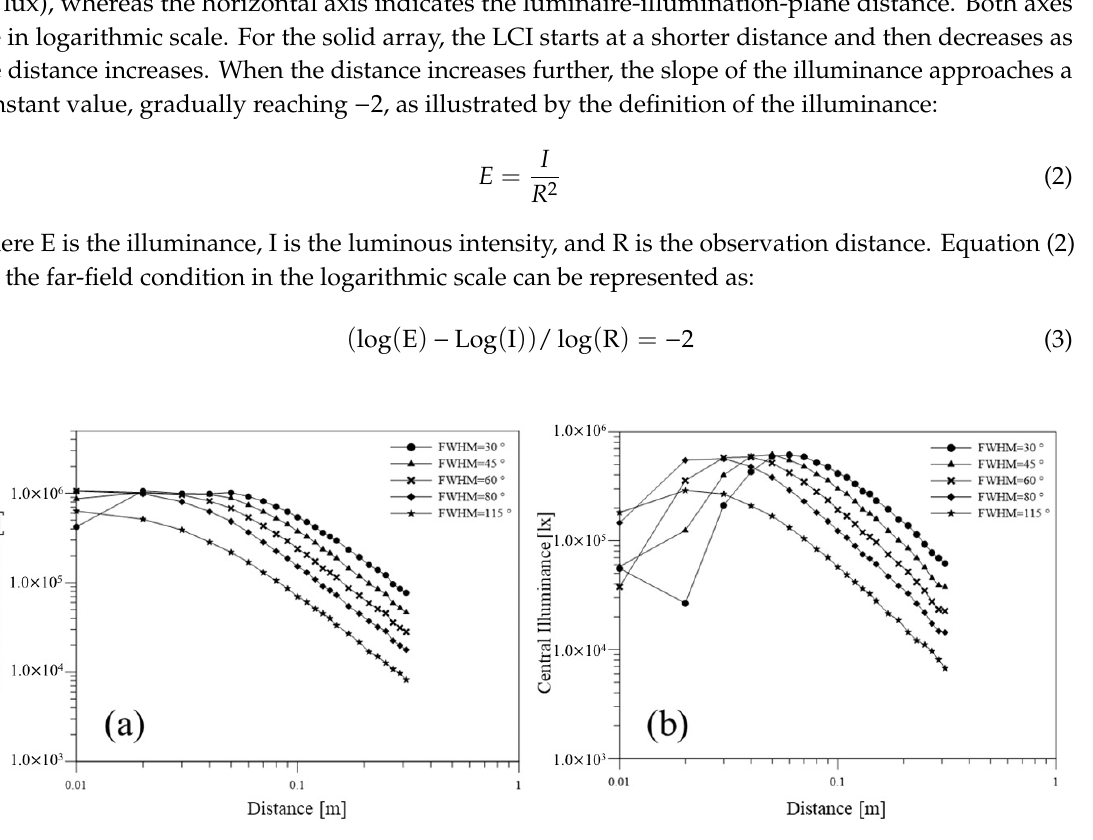
Figure 6. Central illuminance (log scale) versus observation distance (log scale) for ( a ) the solid and ( b ) hollow arrays with different divergent angles of the light source modules.